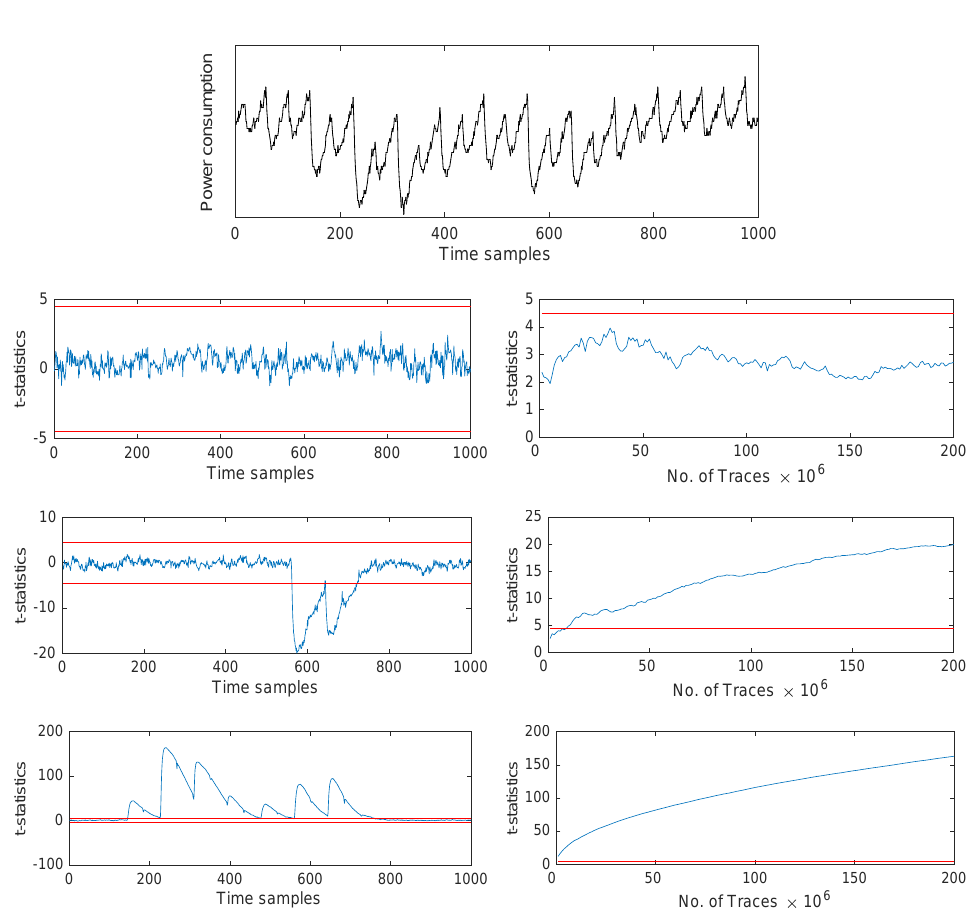
Figure 18: Sample power trace and univariate non-specific t -test results with 200 million measurements for two composed UMA multiplications ( d = 2) based on GF (2 4 ) multipliers without pipeline registers for the inner-domain terms. The second to fourth row show the t -statistics for the statistical moments 1 to 3,